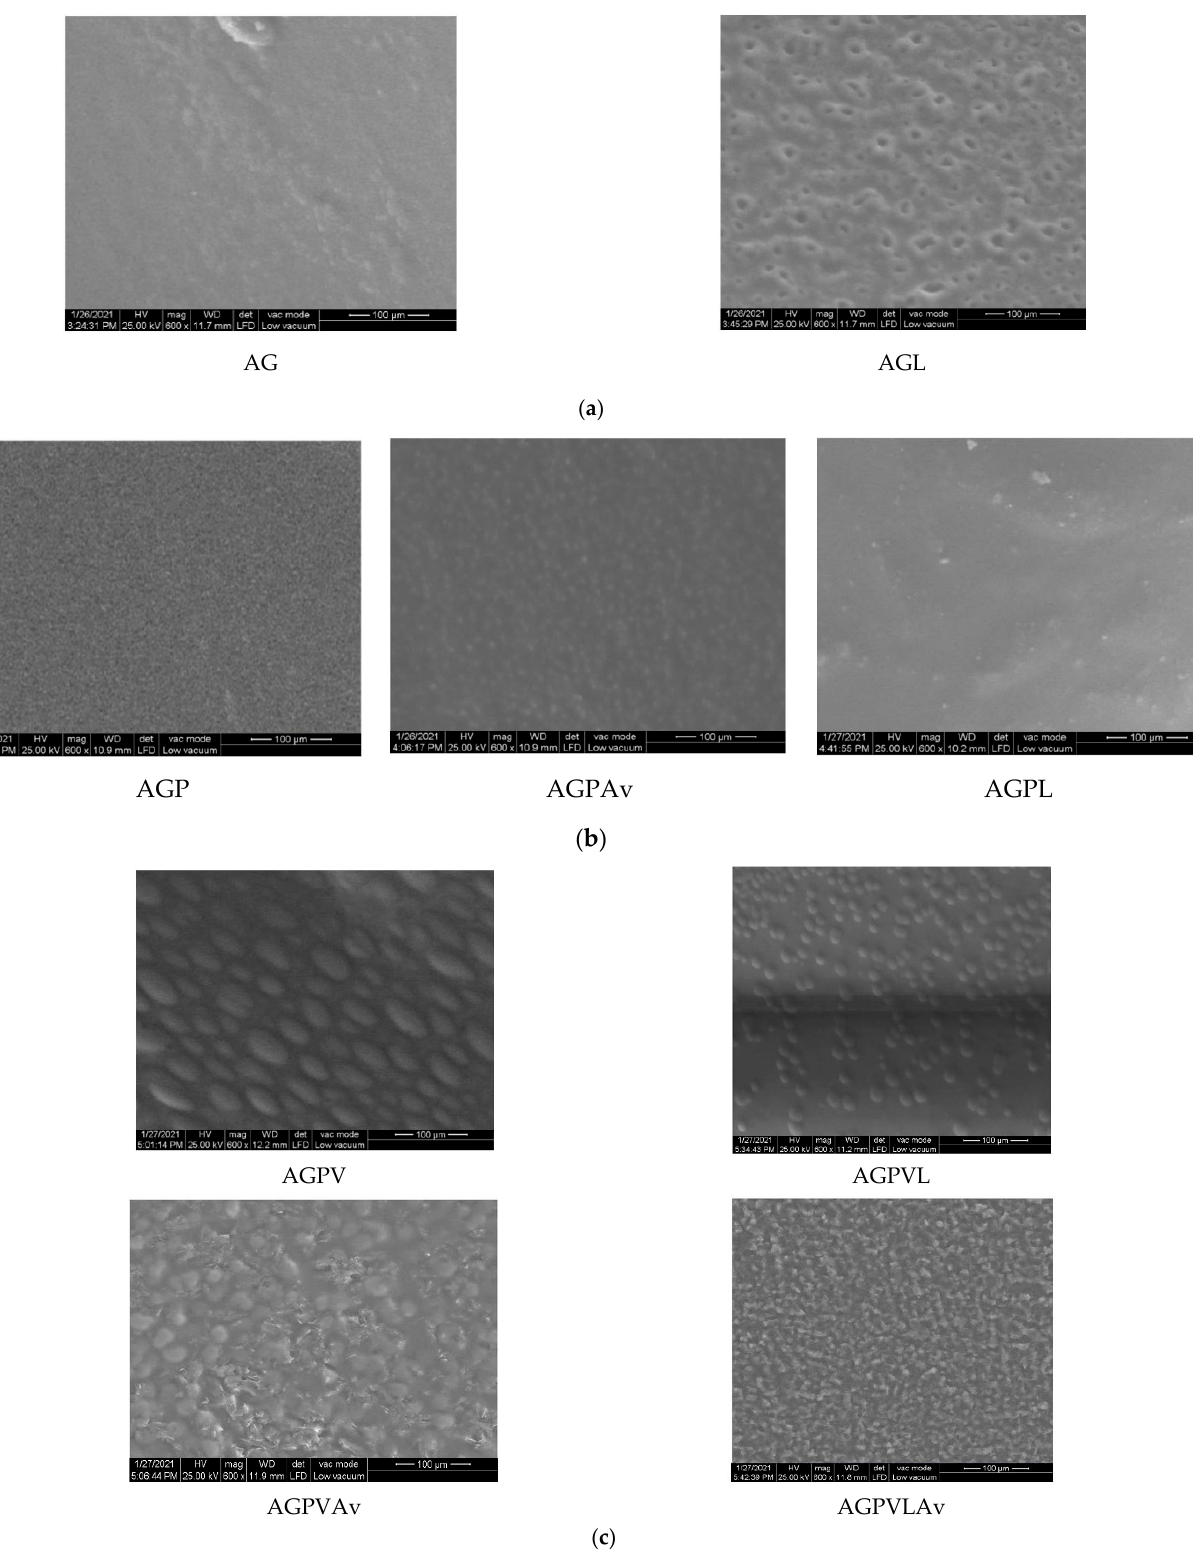
Figure 8. ( a ) SEM analysis for validated membranes based on alginate and Gly and active substances. ( b ) SEM analysis for validated membranes based on alginate, PVP and Gly and active substances. ( c ) SEM analysis for validated membranes based on alginate, PVA and Gly and active substances.